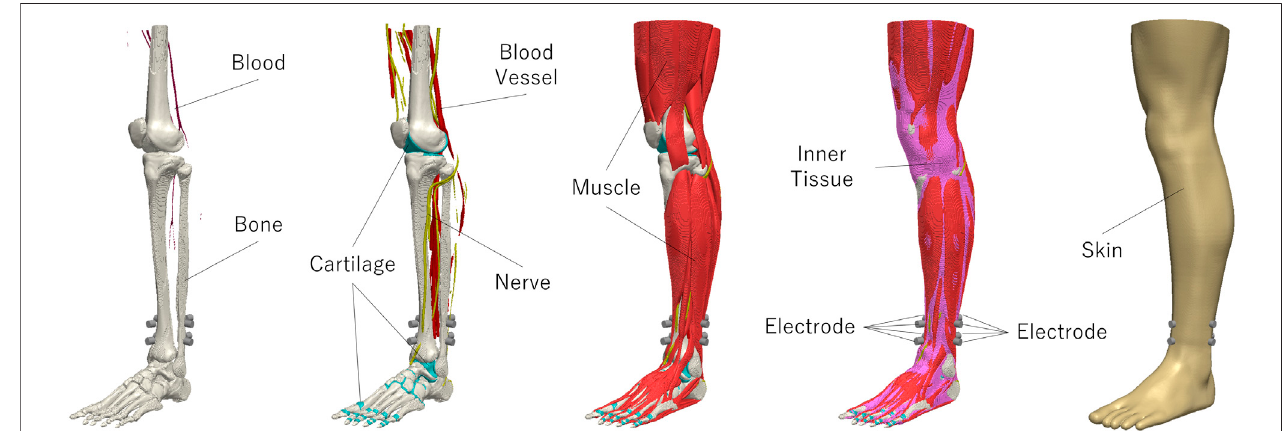
FIGURE 2 | Overview of the processed model of the left leg and position of electrodes.